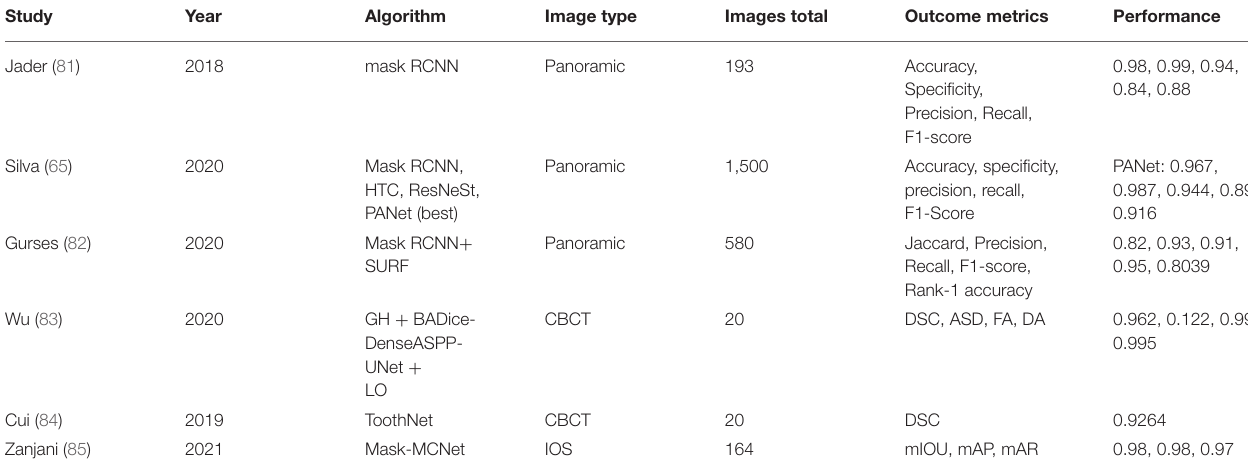
TABLE 5 | Instance segmentation in teeth and related diseases.